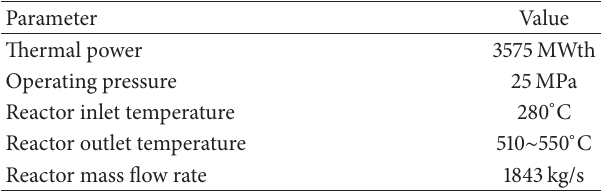
Table 2: The main parameters reference design of the US SCWR.